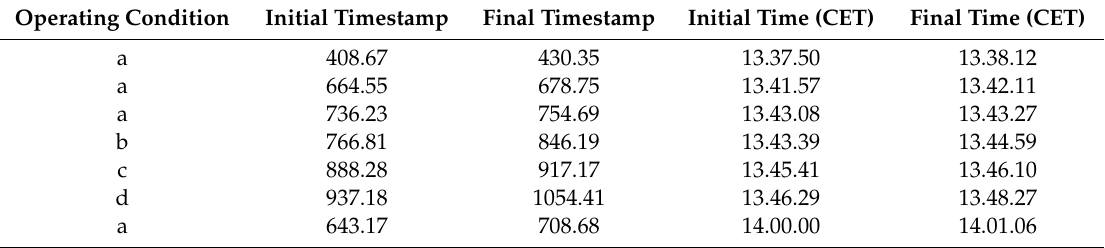
Table 3. TLS sampling